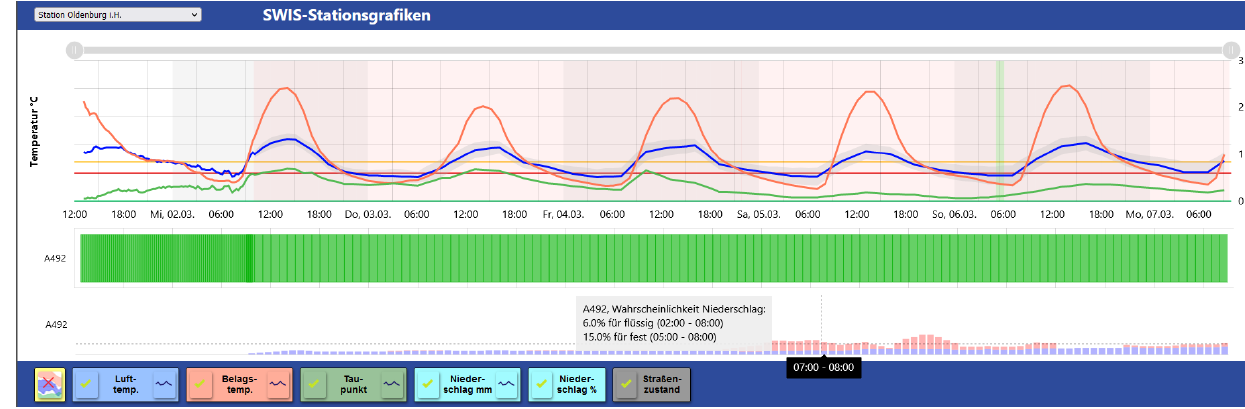
Figure 1. Screenshot of SWIS showing data for the city Oldenburg i.H. including air temperature (blue), road temperature (orange), dew point (green), precipitation (light blue; not visible here because too little precipitation forecasted) in the upper panel, condition of the road (green indicating dry conditions) in the middle panel, and probability of precipitation in the lower panel; © Deutscher